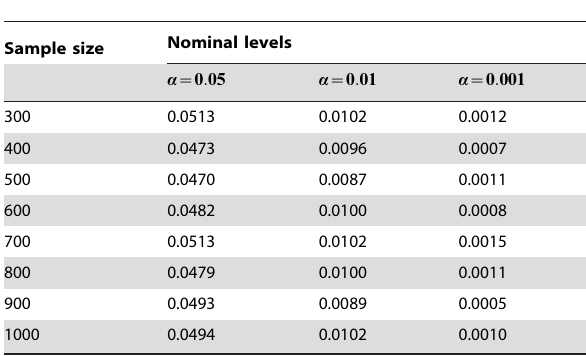
Table 3. Type 1 error rates for the test statistic T GE to test gene-environment interaction, assuming OR g ~ 2 and OR e ~ 2